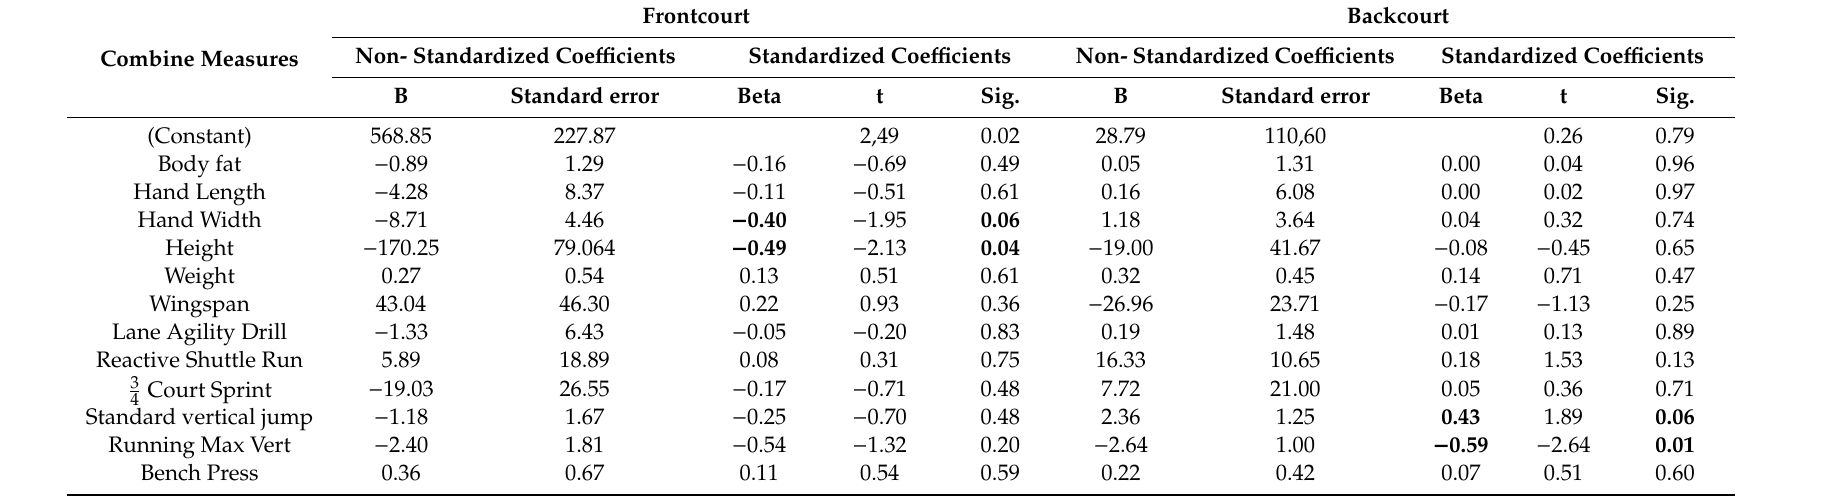
Table 2. E ff ects of Combine test on overall draft position according to playing